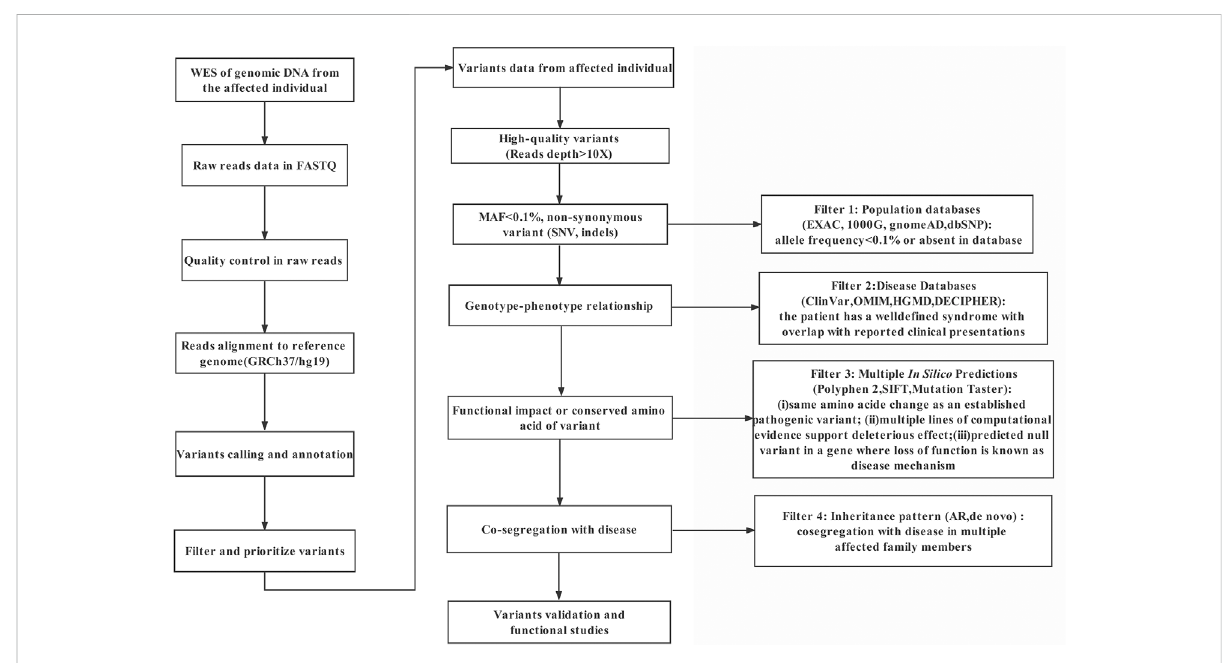
FIGURE 1 The analytical strategy work fl ow for variant fi